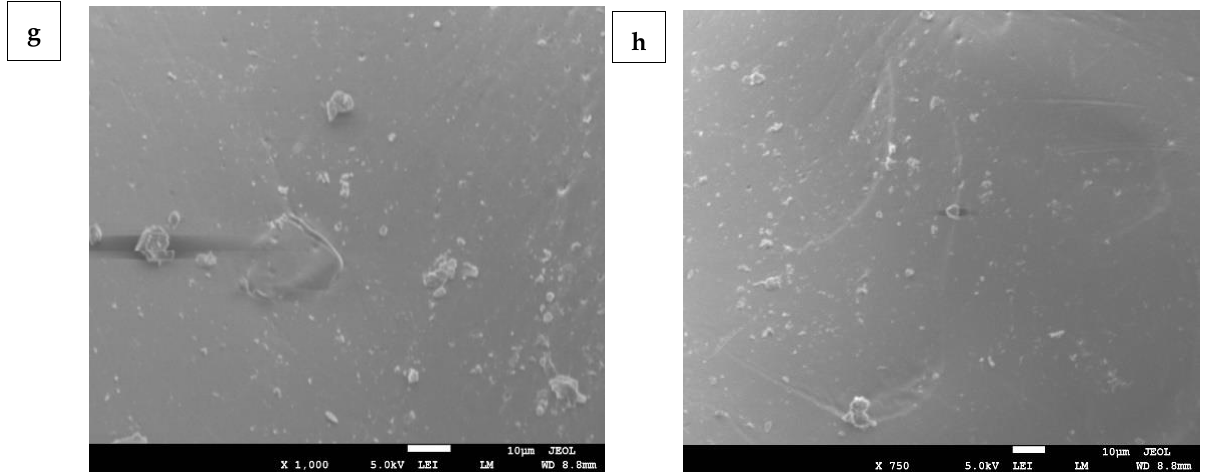
Figure 3. ( a , b ): Photos of SPES pore body, ( c , d ): images of Na-SPES, ( e , f ): images of NH 4 -SPES, and ( g , h ): images of A-SPES smooth body.